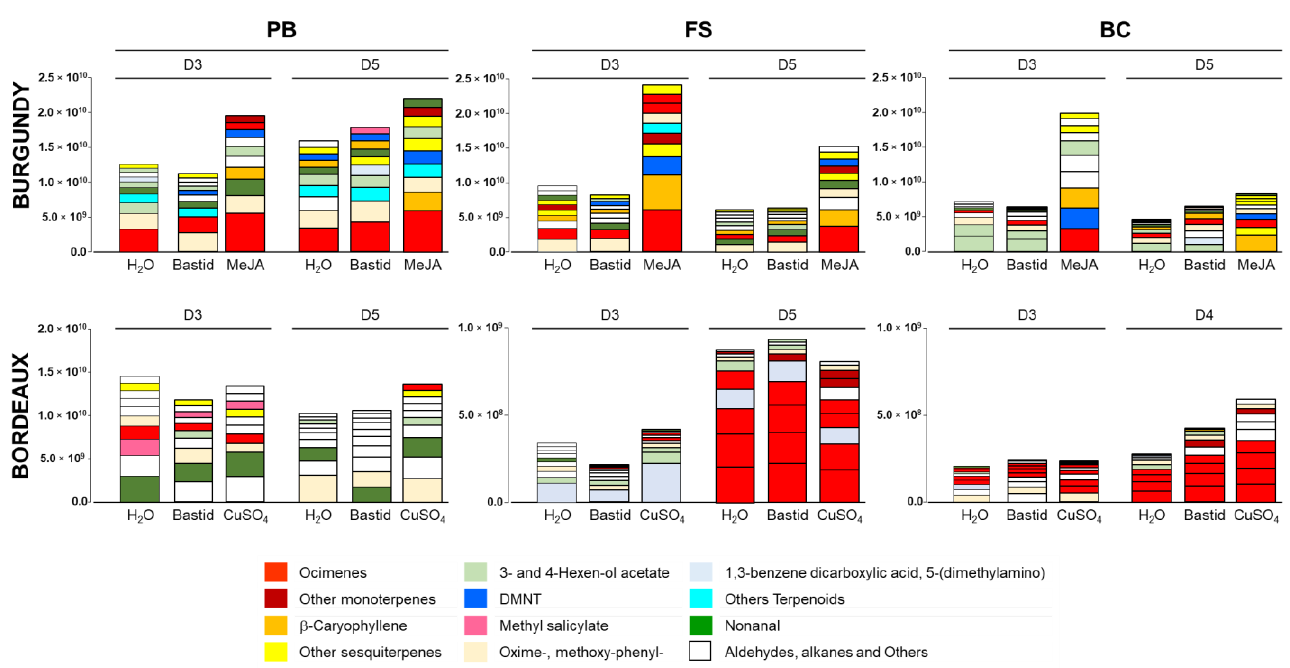
Figure 4. Intensities of the TOP10 VOCs. Peak area intensity values of the TOP10 VOCs detected in Burgundy (cv. Chardonnay) and Bordeaux (cv. Cabernet franc) vineyards in 2019 on D3 and D5 (three- and five-days post treatment) at three phenological stages of grapevine: pre-blossom: PB; fruit-set: FS and bunch-closure: BC. Grapevines were treated with H 2 O (control) or the elicitors Bastid ® , MeJA and CuSO 4 .